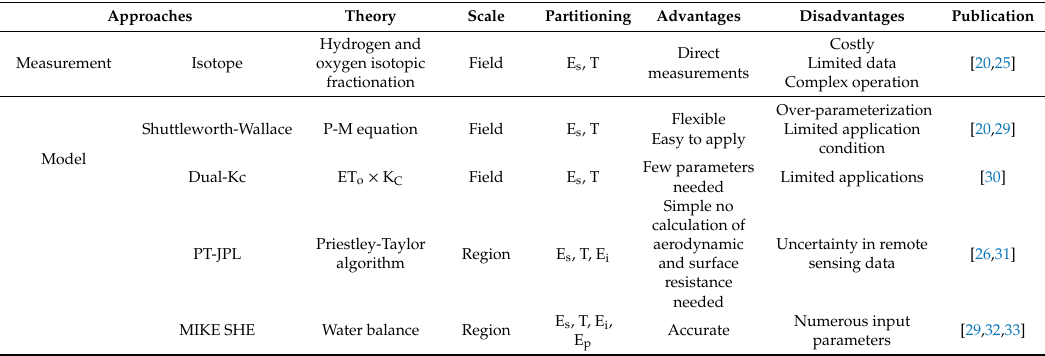
Table 1. A comparison of evapotranspiration partitioning